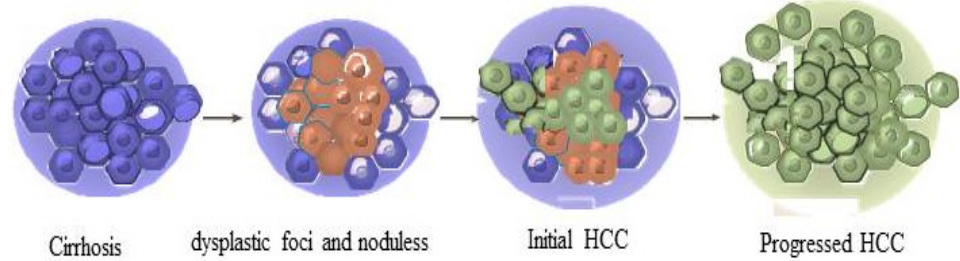
Figure 1. Genetic alterations in HCC. After gaining necessary genetic and epigenetic variations, cirrhosis develops into dysplastic foci and nodules to form HCC.